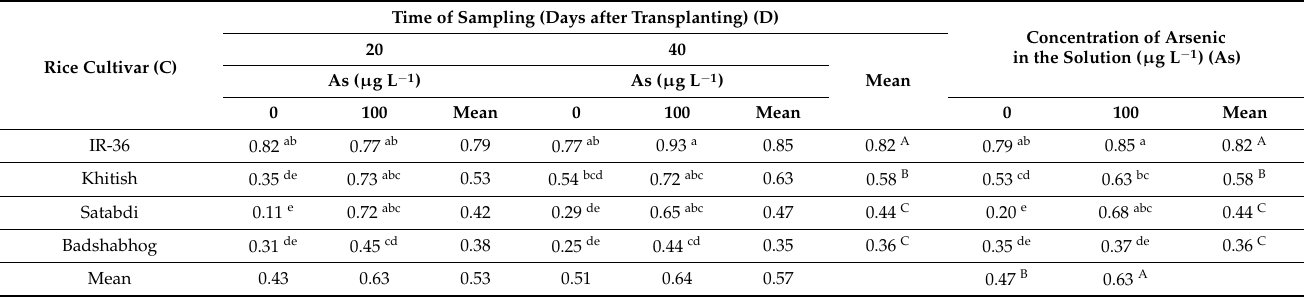
Table 3. Effect of the cultivars and arsenic on the concentration (m N ) of total weak acid secreted by rice roots in solution culture as sampled at twenty and forty days after transplanting